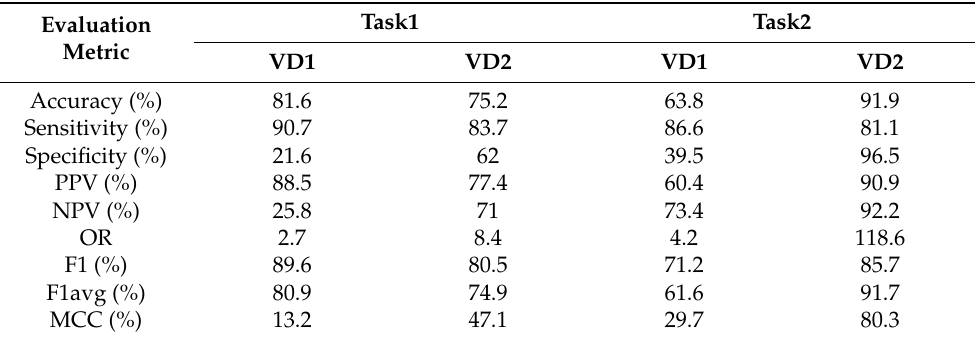
Table 3. Performance evaluation metrics for two classification tasks by using validation datasets 1 and 2,